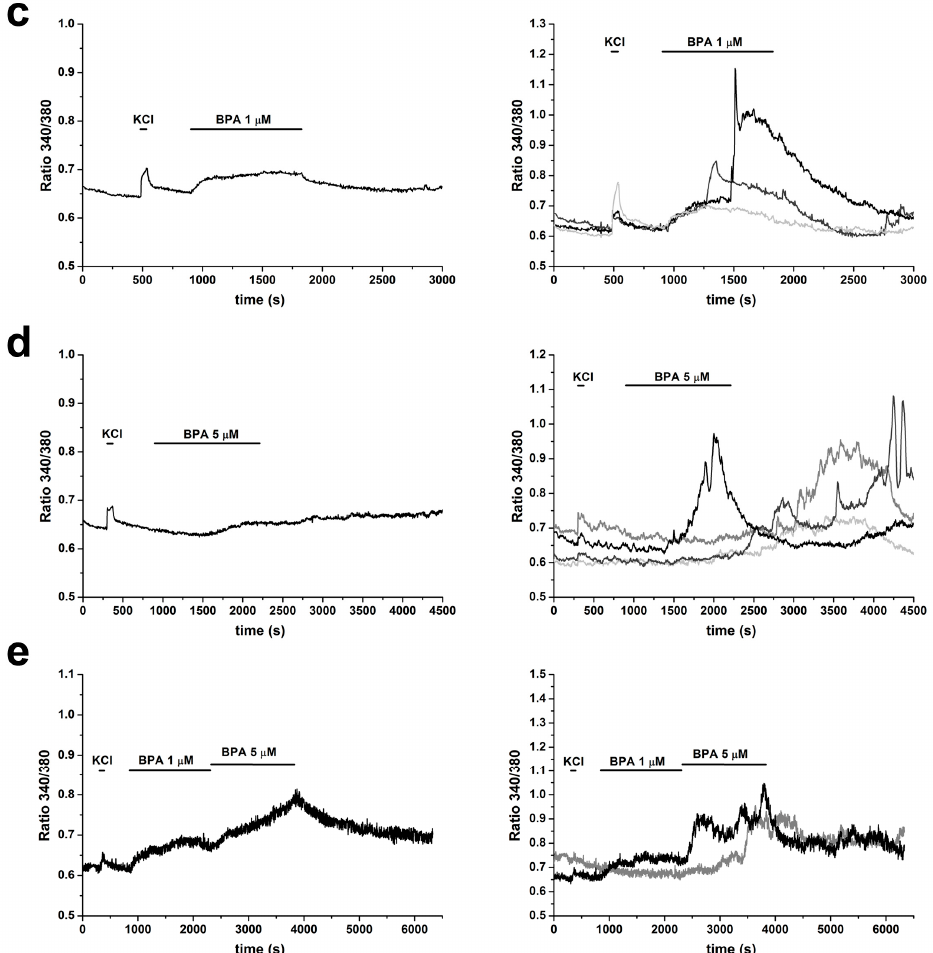
Figure 2. BPA-induced increases in cytosolic calcium concentration. ( a – d ) Changes in [Ca 2 + ] i in response to 10 nM, 200 nM, 1 μ M and 5 μ M BPA, respectively. ( Left ) Averaged responses from all cells from a single experiment. ( Right ) Examples of responses form single cells. Before the application of BPA, cells were chemically depolarized with 40 mM KCl and the increase in [Ca 2+ ] i due to influx through voltage-dependent channels was recorded. ( e ) Responses to incremental doses of BPA: ( Left ) averaged responses; and ( Right ) representative responses of individual cells. Inset in ( a ): averaged trace from n = 55 cells maintained for 30 min in normal physiological solution.